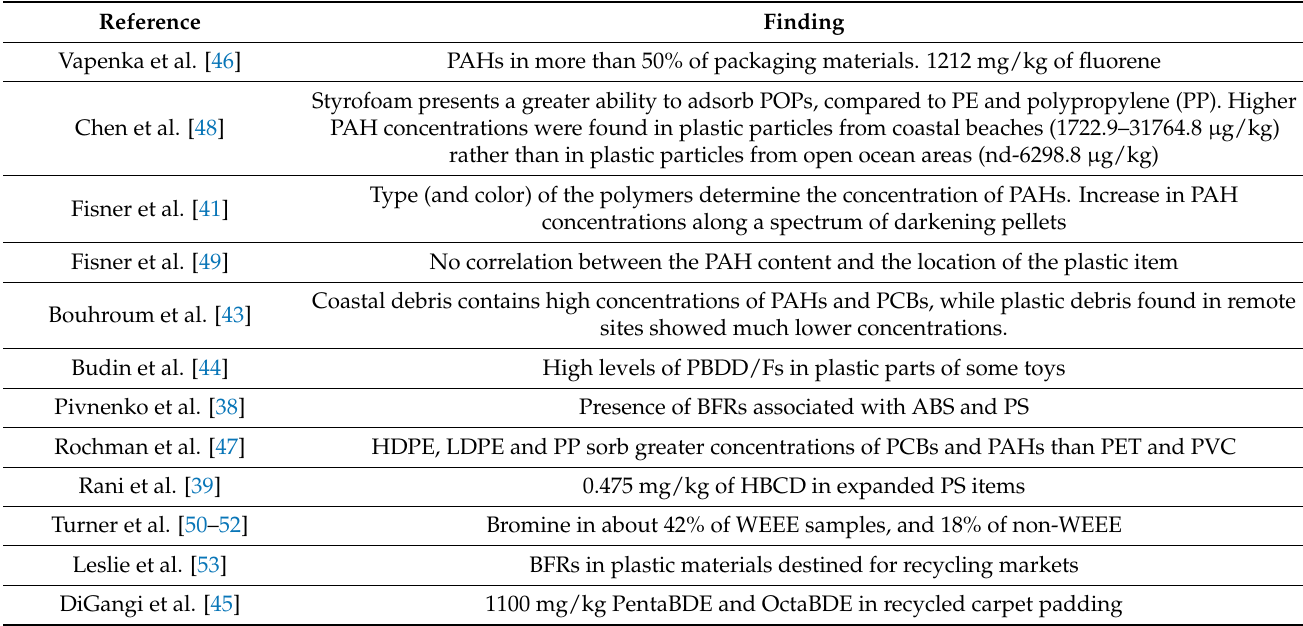
Table 1. Summary of important PAHs and POPs levels found in recycled